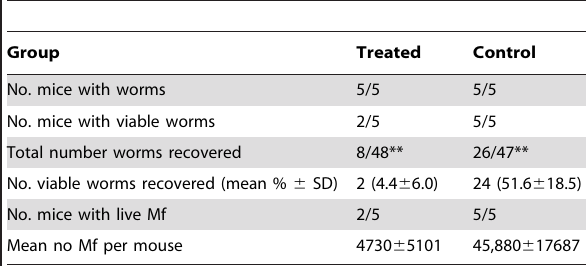
Table 1. Recovery of adult worms and Mf from mice post- NVP-AUY922